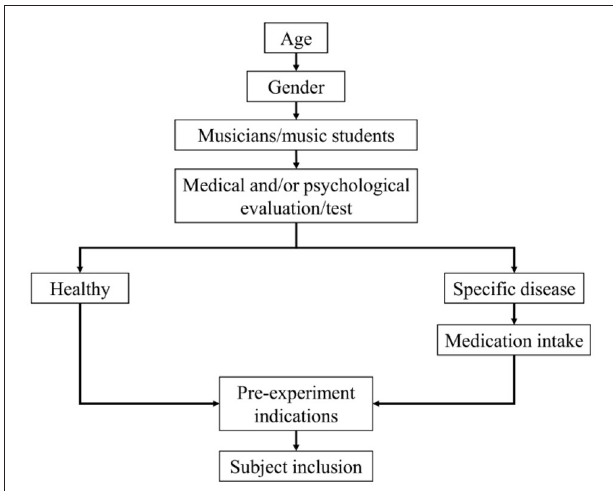
FIGURE 2 | A general flow diagram to select and apply inclusion and exclusion